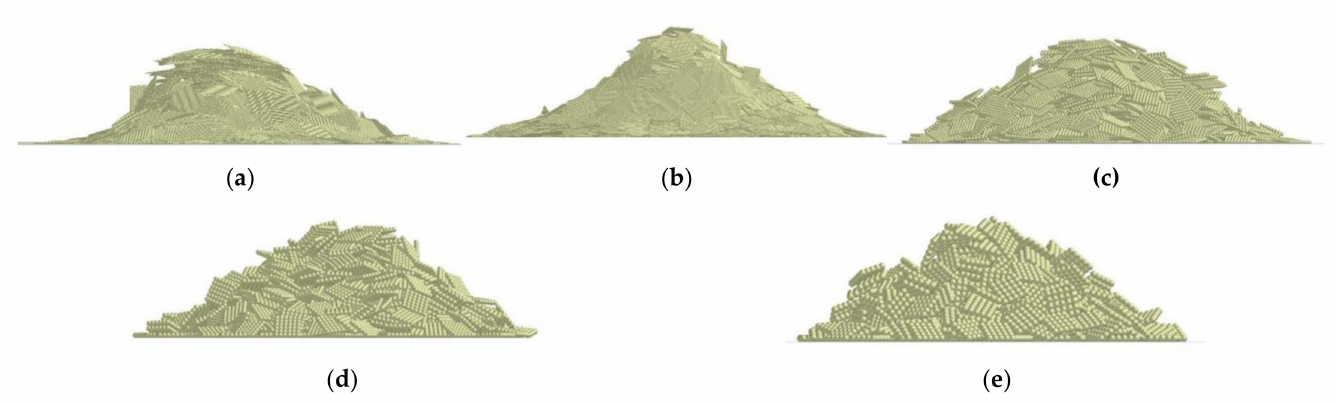
Figure 7. Simulation stacks of five sugarcane leaf models with different filling particle radii; ( a ) r = 0.5 mm, ( b ) r = 1.0 mm, ( c ) r = 2.0 mm, ( d ) r = 3.0 mm, ( e ) r = 4.0